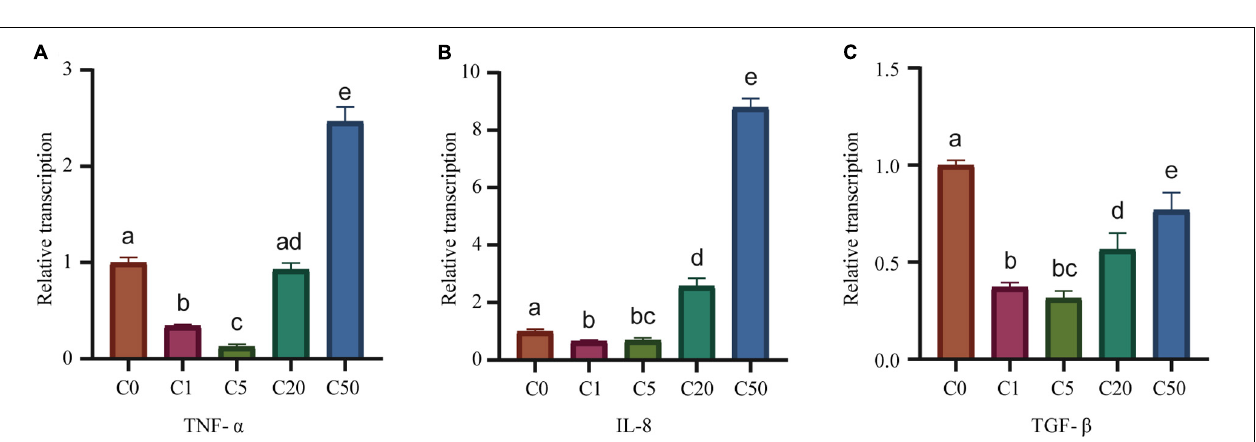
FIGURE 4 | Changes in inflammatory factor gene expression in Xenopus laevis liver under different MC-LR concentration treatments. (A) TNF- α . (B) IL-8. (C) TGF- β . Numbers after the letter C in the group names indicate MC-LR concentrations. Different letters above the bars indicate significant differences between data.